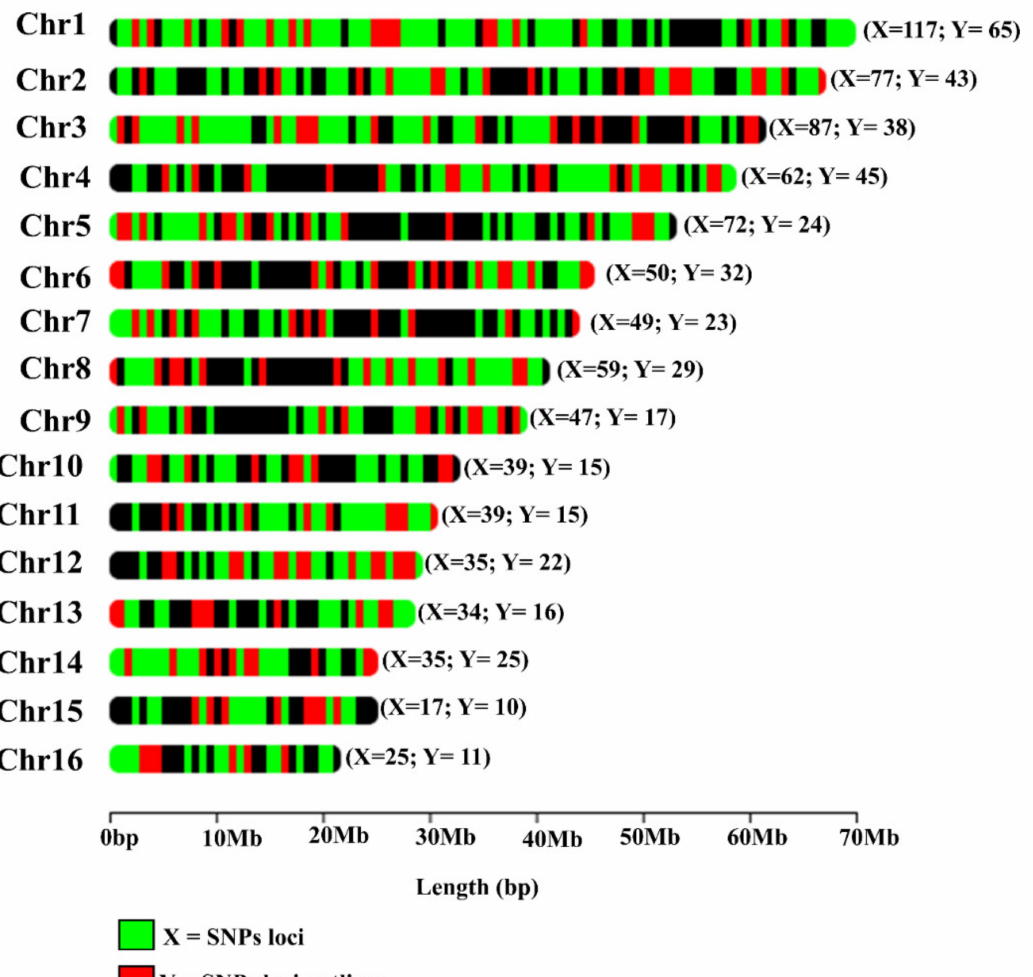
Figure 2. Distribution of 1274 SNPs loci aligned against E. guineensis chromosomes (PRJNA192219), visualized through the R package chromoMap. X = SNPs loci; Y = SNPs loci